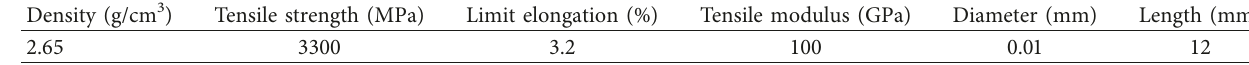
Table 1: Physical and mechanical indexes of basalt fiber.